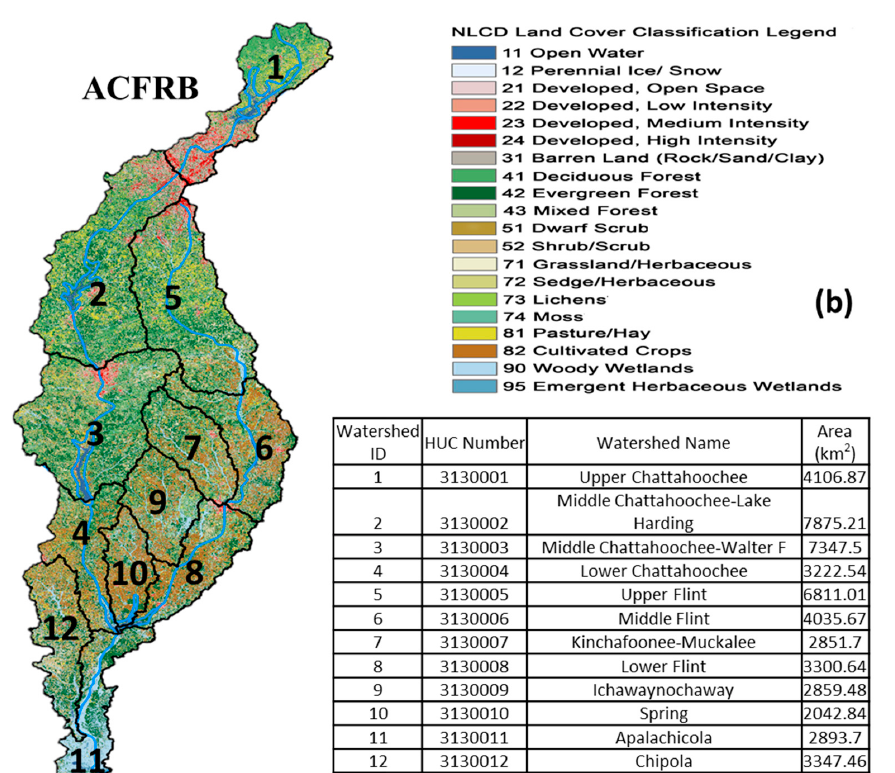
Figure 1. Location of the Apalachicola–Chattahoochee–Flint River basin (ACFRB) of the Florida panhandle, USA. ( a ) Hurricanes and tropical storms passed through or highly impacted the ACFRB from 1966 to 2018. ( b ) The name, area, and land use of the 12 watersheds at the ACFRB. USGS #02359170 is the US Geological Survey gage number.